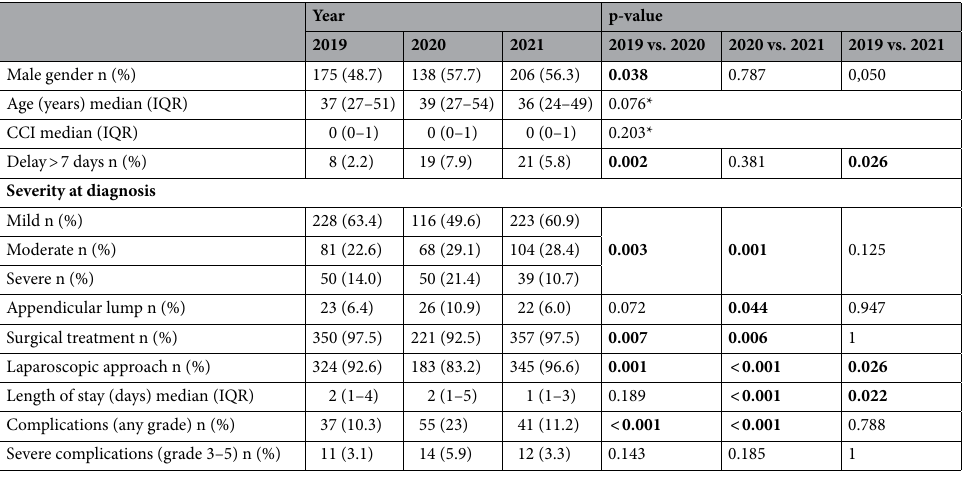
Table 2. Appendicitis patients characteristics. CCI Charlson Comorbidity Index. *Non-significant p-value in Kruskal–Wallis test, therefore no multiple comparations were performed.